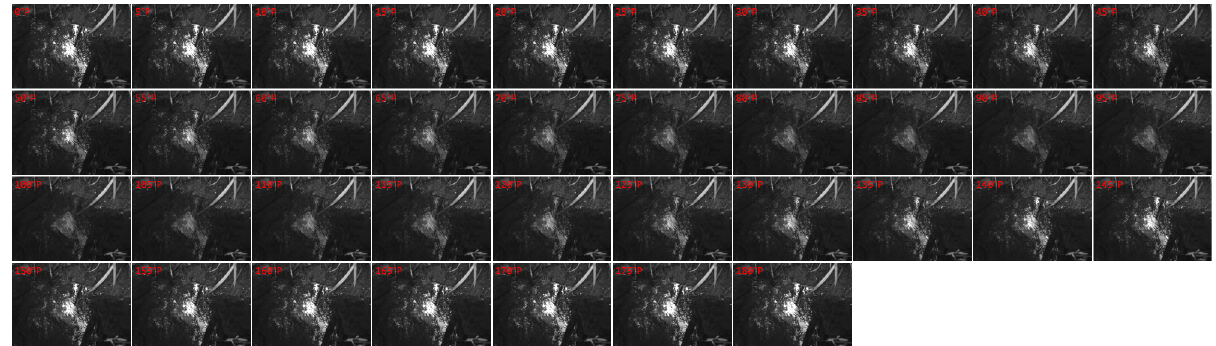
Figure 7. Simulated directional polarization images for case Ⅲ